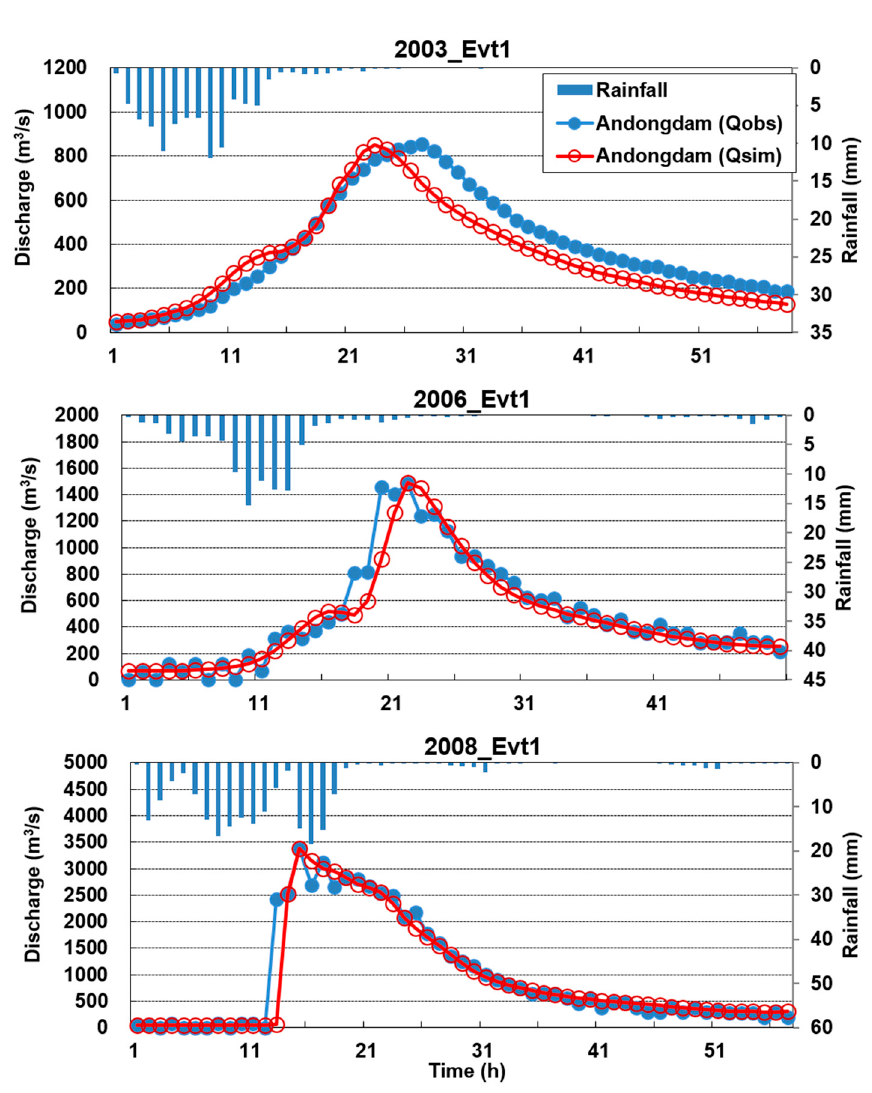
Figure 6. Observed hydrographs and simulated hydrographs by parameter calibration for three events in the Andongdam catchment.